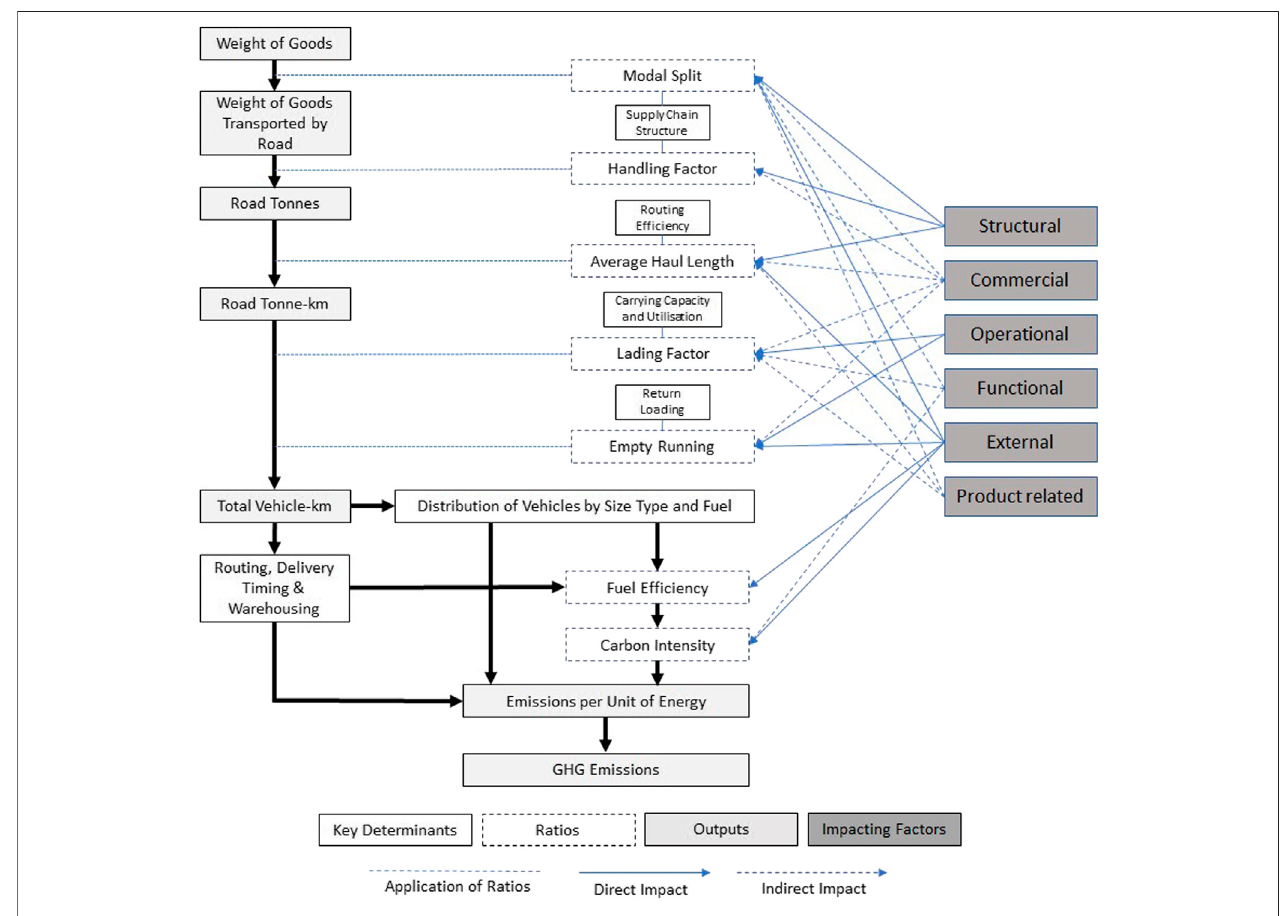
FIGURE 5 | Key determinants of freight transport emissions (Based on Piecyk and McKinnon, 2010; McKinnon et al., 2014; McKinnon, 2018).